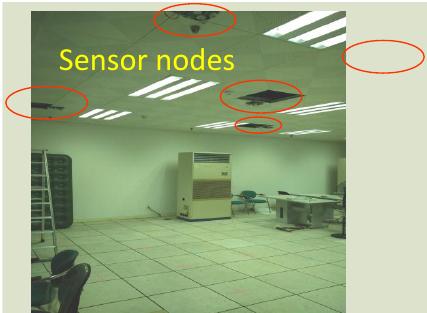
Figure 8. Deployment of the sensor nodes. The red circles are the locations of sensor